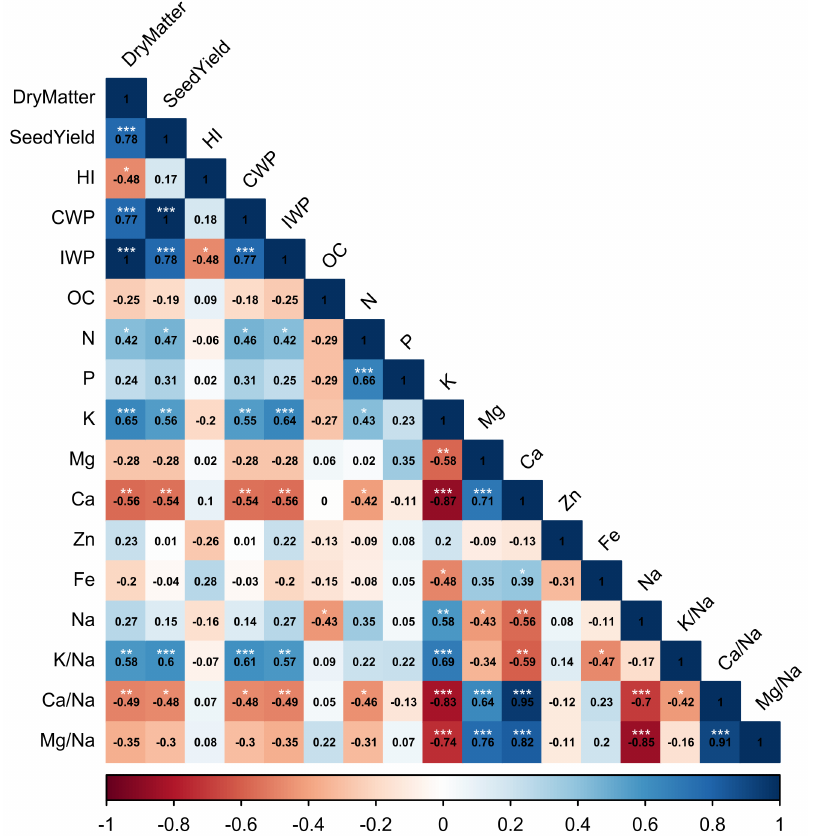
Figure 3. Correlation among seed and dry matter yield, harvest index, crop and irrigation water productivity, and different leaf nutrient contents. *, **, and *** indicate significant differences at p < 0.05, 0.01, and 0.001, respectively. The color gradient scale indicates the Pearson coefficient of